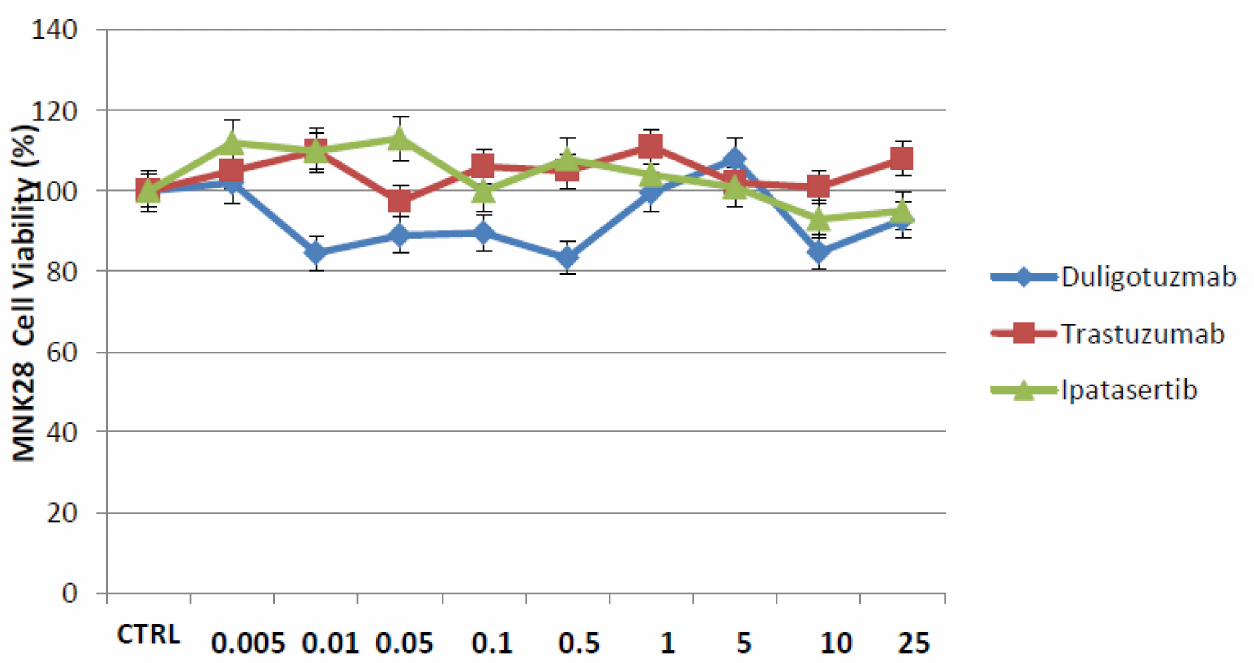
Figure 2. Effect of Trastuzumab, Ipatasertib and Duligotuzmab on cell proliferation in MNK28, human gastric cancer cell line, treated with different concentration of each drug for 72 h and evaluated for proliferation by MTT staining, as described in Materials and Methods. The results are the median of three separate experiments, each performed in